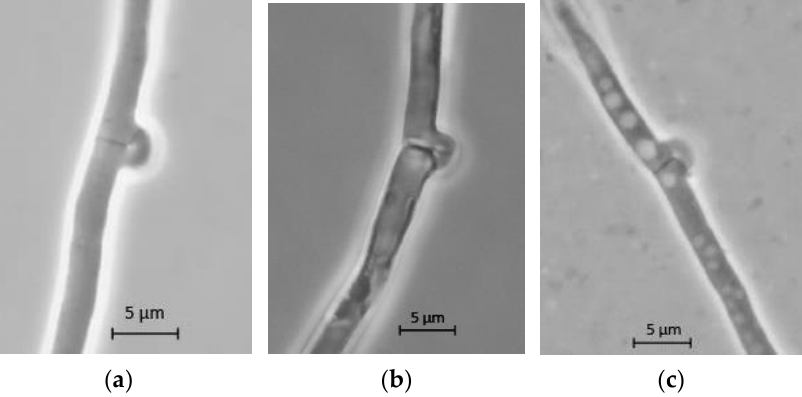
Figure 9. Clamp connections in terminal hyphae of P. ostreatus in culture media with different nutrient conditions and copper sulfate 1 mM at the 7th culture day: ( a ) Carbon and nitrogen sufficient condition, GY4515 + Cu 2+ ; ( b ) Carbon limited and nitrogen sufficient condition, GY0515 + Cu 2+ ; ( c ) Carbon-sufficient and nitrogen-limited condition GY4504 + Cu 2+ .